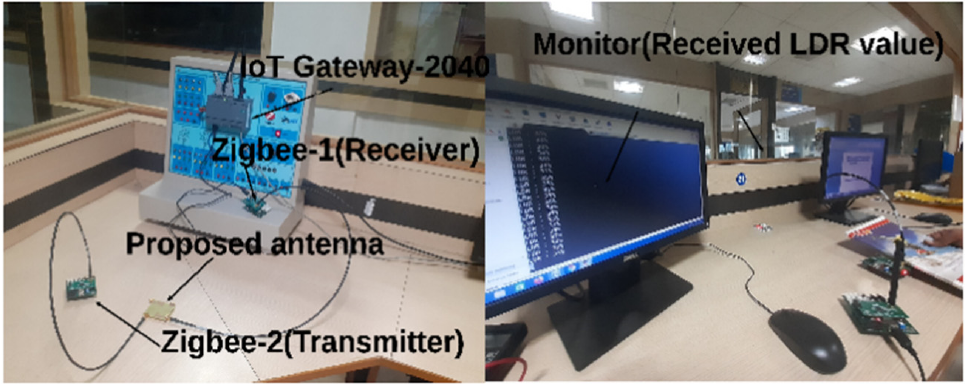
Figure 17. Photograph of the smart home experimental setup. The ZigBee device has an in-built LDR sensor to detect incident light for smart home applications. The proposed antennas are connected with the first and second ZigBee devices. One antenna is acting as a transmitter, and another is working as a receiver. In this real-time IoT implementation, the LDR sensor sends the sensed data (for two different conditions, with light and without light) through the proposed antenna, which is connected to the second ZigBee device. The transmitted data is received by the receiving antenna, connected to the first ZigBee device. In order to store and retrieve data from the cloud for IoT applications, the first ZigBee device is connected to the IoT development kit, as shown in Figure